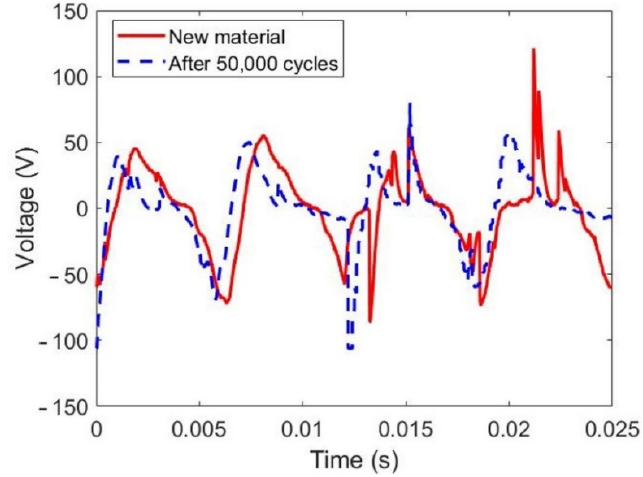
Figure 8. Durability evaluation of the output voltages of a new HDR-TENG compared to an HDR- TENG after 50,000 cycles of rotation. The specification of the HDR-TENG: h is 1.3 mm, the rotation speed is 12,800 rpm with a 25 cm wire length, and the load resistance is 10 M Ω .